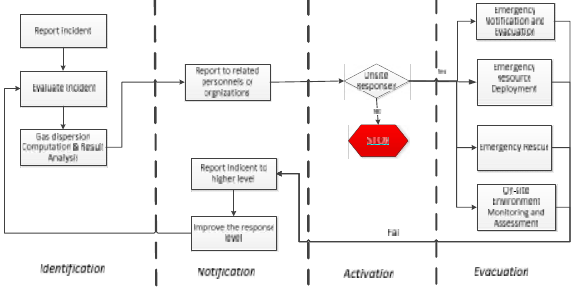
Figure 4. Simplified diagram of incident emergency response